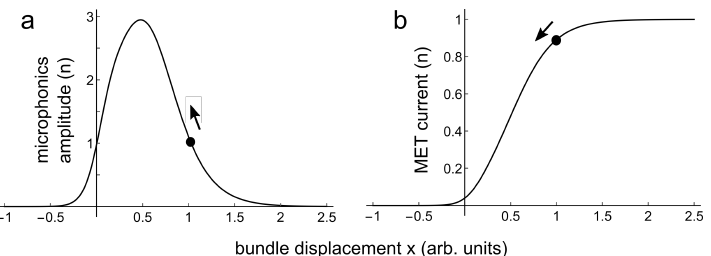
Figure 5. ( a ) Relation between bundle displacement and microphonics amplitude for parameters a = 2.62, α 1 = 8.77, α 2 = 4.32, x 1 = 0.0552, x 2 = 0.514, β = 0.363. ( b ) Relation between bundle displace- ment and MET current for the same values of α 1 , α 2 , x 1 , x 2 . The black dots in ( a , b ) are at corresponding bundle displacement starting positions. The arrows indicate the direction along curves ( a , b ) of the return of microphonics amplitude and MET current to their equilibrium